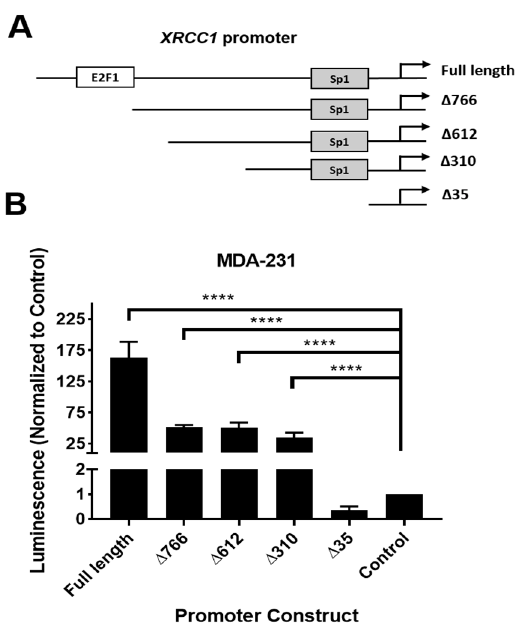
Figure 1. XRCC1 promoter expression in MDA-231 cells has actively transcribed regions between − 612 and − 35. ( A ) XRCC1 promoter fragments with known transcription factor sites were inserted into the pGL3 luciferase reporter. ( B ) Reporter plasmids were transfected into MDA-231, and luminescence was read after 24 h. **** p < 0.0001.